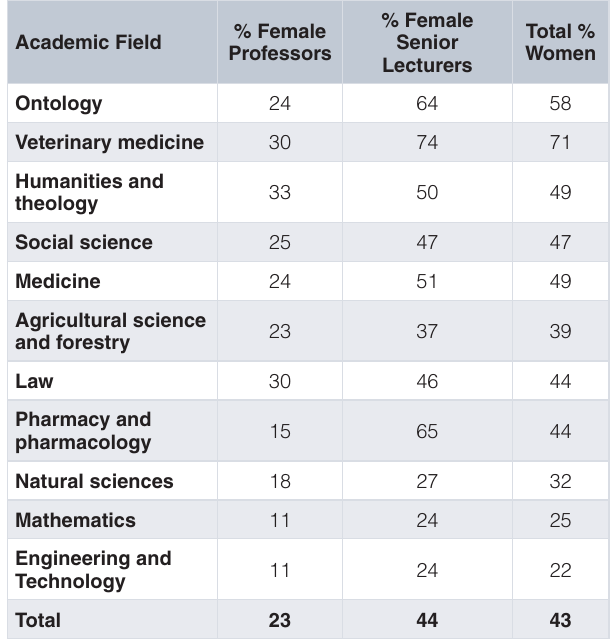
Table 1. Percentages of female professors and senior lecturers, as well as total percentage of women in different disciplines in Sweden, based on data presented in